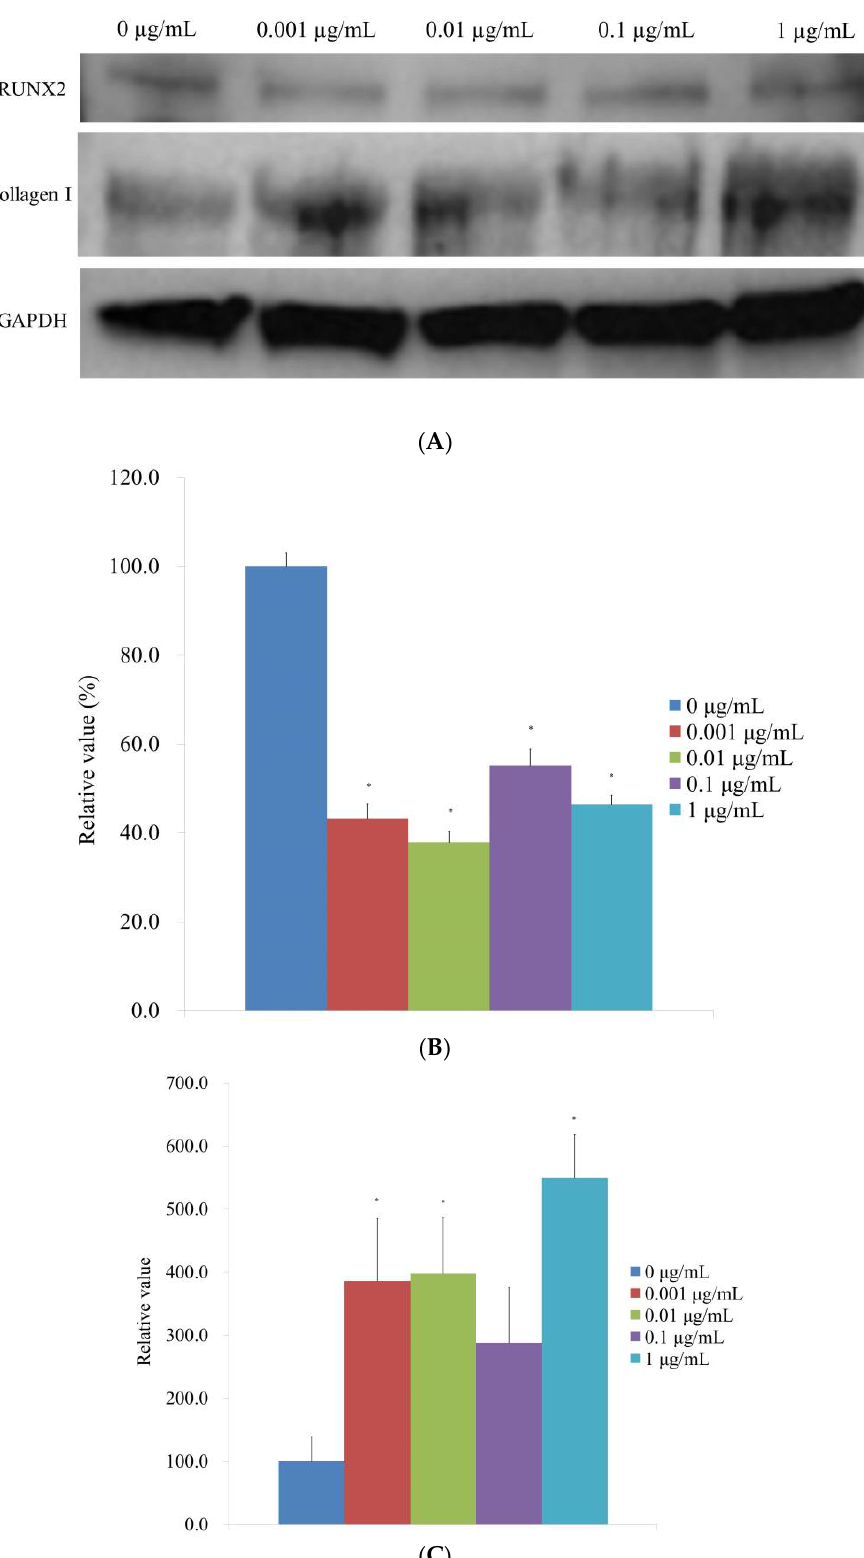
Figure 8. Western blot analysis. ( A ) Type I collagen and Runt-related transcription factor 2 expressions when CMT is added to the culture. ( B ) Normalization of the protein expressions of the Runt-related transcription factor 2. * p < 0.05 versus the 0 μg /mL on Day 14. ( C ). Normalization of the protein expressions of the type I collagen. * p < 0.05 versus the 0 μg /mL on Day 14.